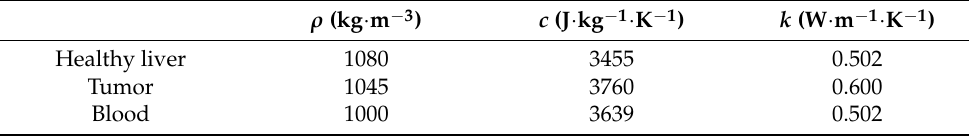
Figure 2. Porosity variability inside tumor domain. Table 1. Thermal properties employed for the different materials